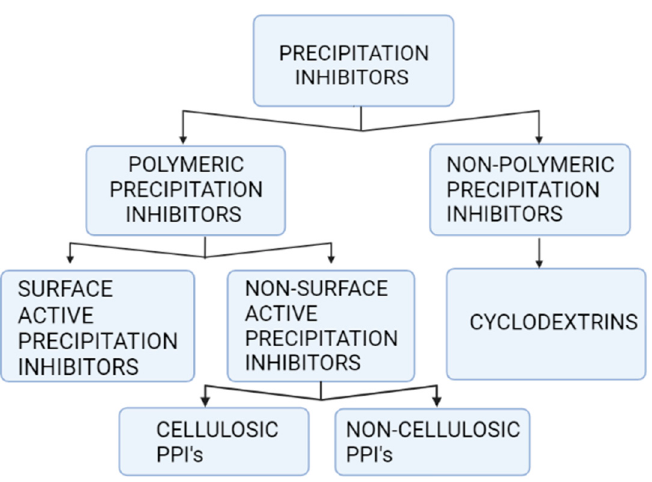
Figure 2. Precipitation